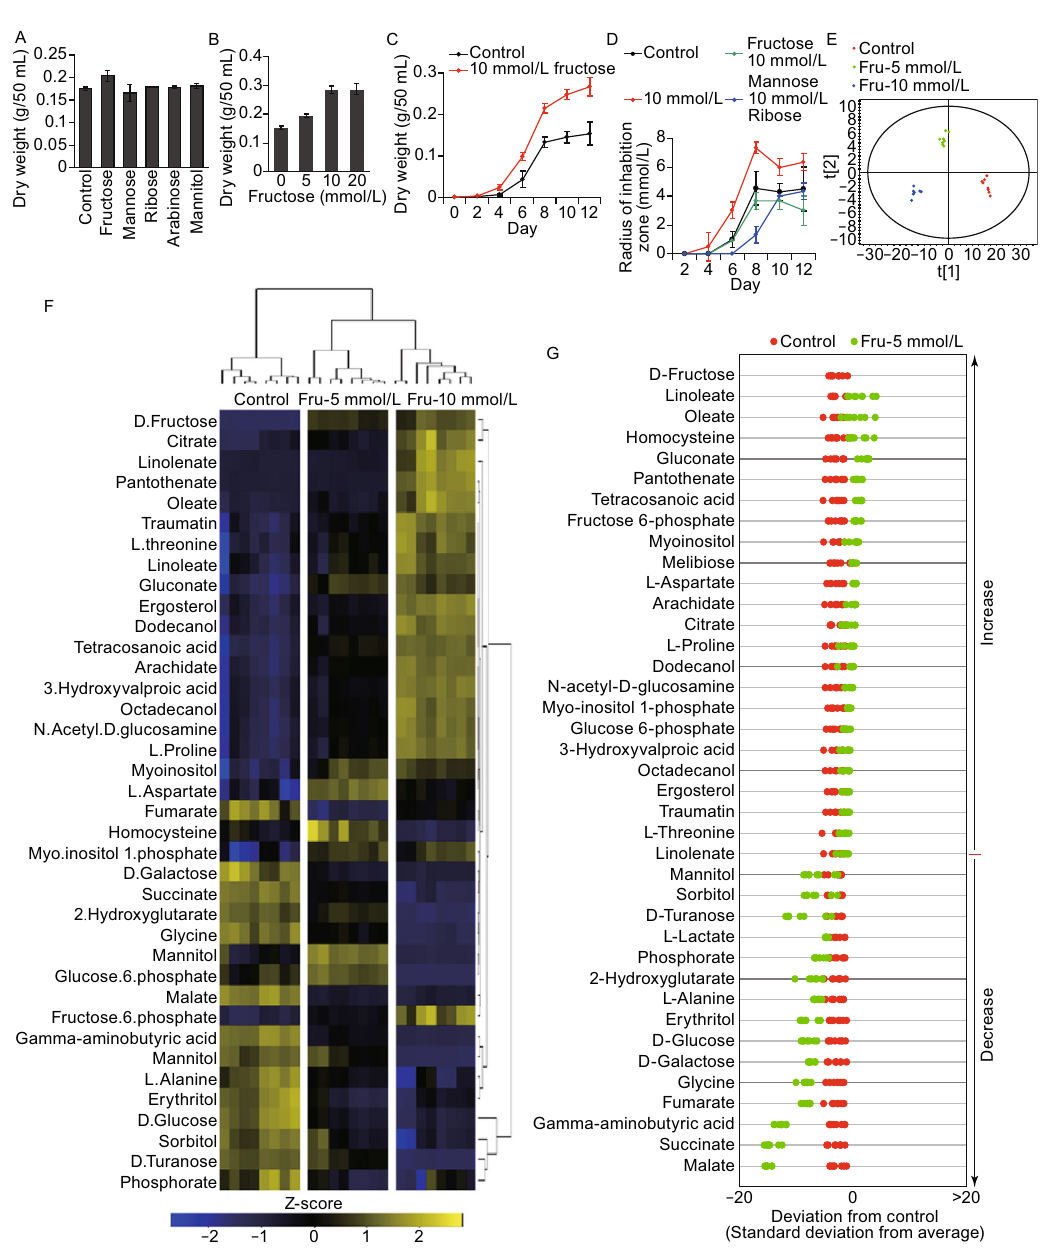
>20 Deviation from control (Standard deviation from average) Figure 1. Fructose promotes growth and antifungal activity and affects the metabolic pro fi le of P . citrinum W1. (A) P. citrinum W1 biomass in media containing 5 mmol/L each of different exogenous nutrients. (B) Biomass in different concentrations of fructose. (C) Biomass obtained over time in media containing 10 mmol/L fructose, as measured at the indicated time points. (D) The score plot of the OPLS-DA model from all detected metabolites. (E) Heat map of unsupervised hierarchical clustering of differential abundance of metabolites. Yellow and dark blue indicate an increase and decrease of the metabolites, respectively, scaled to the mean and standard deviation (SD) of the row metabolite level (See color scale). (F and G) Z-score scatter diagrams of differential metabolite expression, as compared to the control group, for P. citrinum W1 grown in 5 mmol/L and 10 mmol/L fructose, respectively. The data from test groups are separately scaled to the mean and SD of the control. Each point represents one metabolite in one technical repeat and is colored by sample types. (H) The number of metabolites increased and decreased in different functional categories. (I and J) S-plots generated from the OPLS-DA data, identifying biomarkers that distinguish the two test groups from the control (component p[1]) and those that separate the two test conditions (component p[2]), respectively. Triangles represent metabolites, and candidate biomarkers are indicated by red